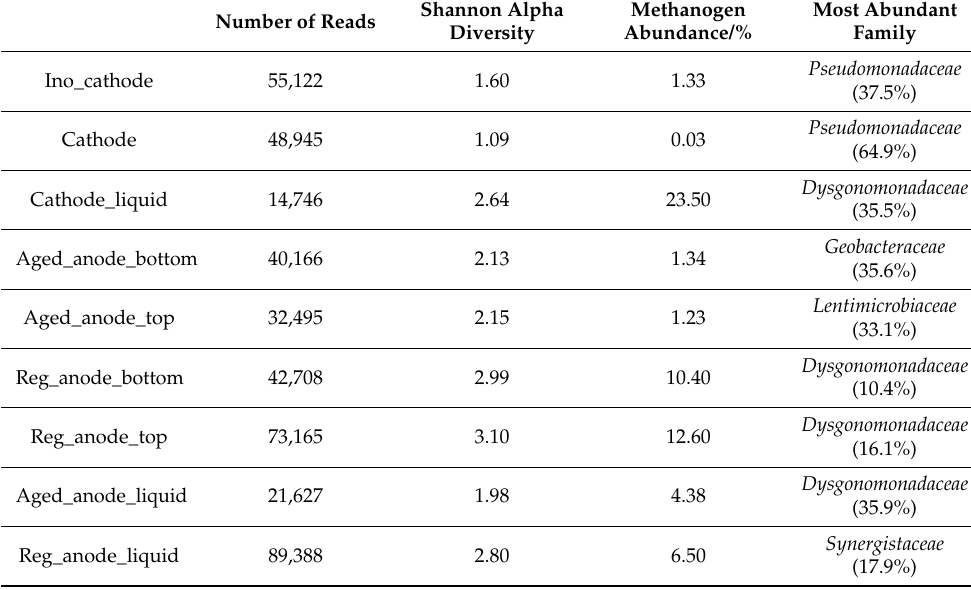
Figure 10. Rarefaction curves of the sequenced sample. Table 2. An overview of the sequencing results. Sampling location was indicated with “top” (top of the electrode), “bottom” (bottom of the electrode” or “liquid” (electrolyte sample). “Aged” or regenerated anode samples were indicated with “Aged” or “Reg”.